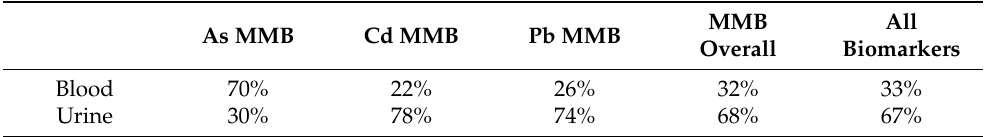
Table 6. Weights highlighting the contribution of each biomarker to the mixture effect of metals on cystatin C. Larger weights indicated higher contributions to the mixture